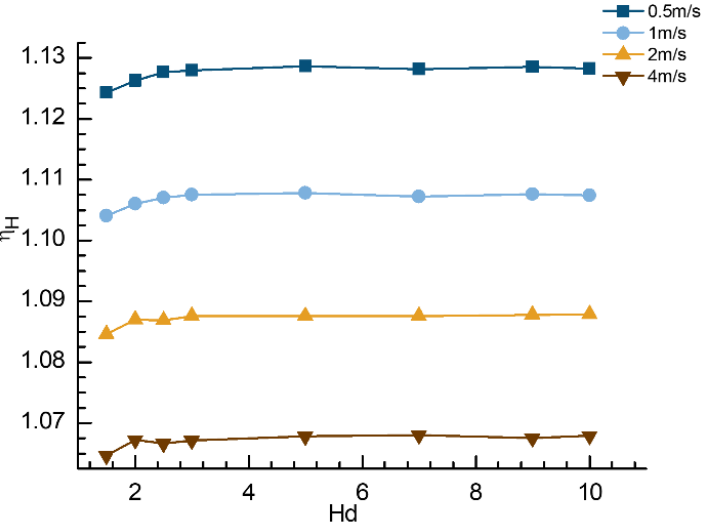
Figure 17. Hull efficiency for self-propelled UUV.